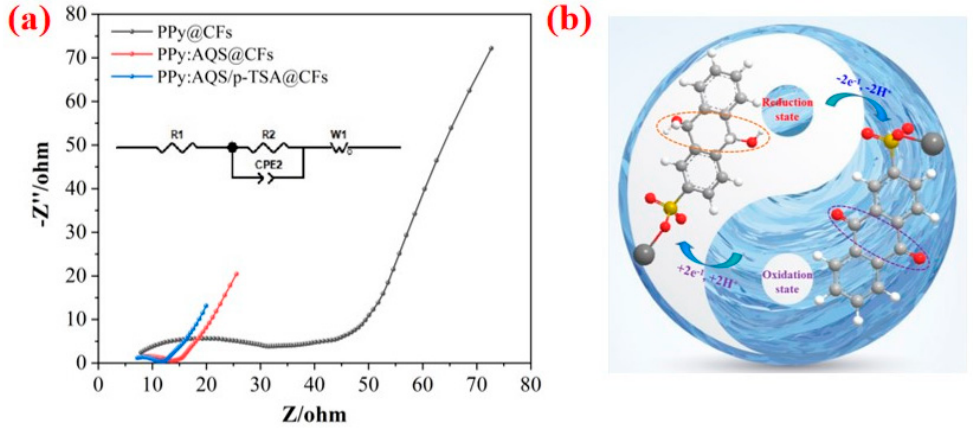
Figure 6. ( a ) Nyquist plots of PPy@CFs, PPy:AQS@CFs, and PPy:AQS/p-TSA@CFs, and ( b ) the mechanism of AQS in the electrochemical process for PPy:AQS/p-TSA@CFs electrode materials.